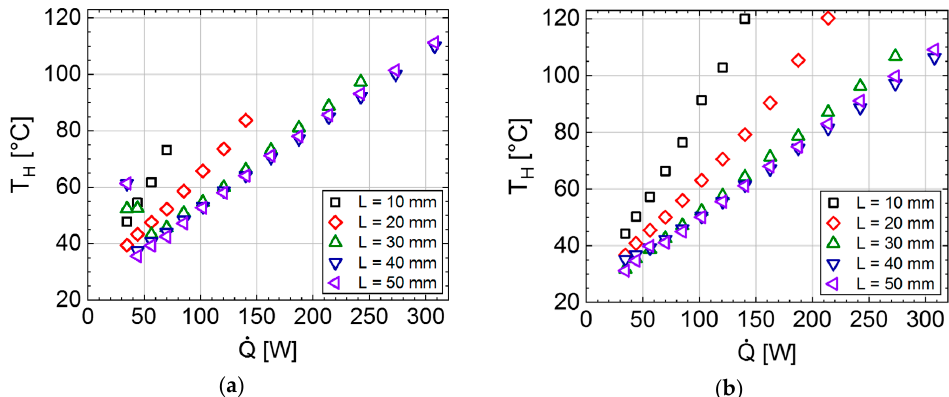
Figure 7. Plot of heater temperature 𝑇 (cid:3009) vs. heating power 𝑄 ´ for a heater width of 25 mm and condenser plate widths 𝐿 of 10–50 mm for PHP with channel size of 1.5 × 1.5 mm 2 . ( a ) horizontal orientation; ( b ) vertical orientation.